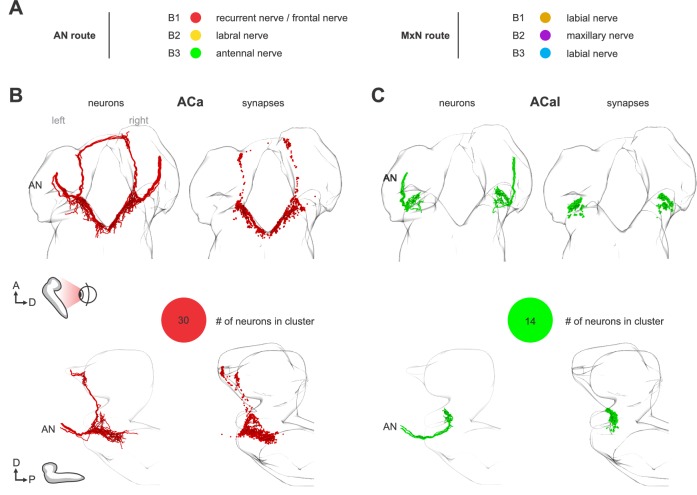
EM reconstruction of compartment forming sensory neurons and their synaptic sites.(A) Peripheral origin of AN and MxN axon bundles of pharyngeal nerves and nerve branches. The recurrent nerve, the frontal nerve labral nerve and the antennal nerve enter the brain as single morphologically indistinguishable nerve collective (termed as a whole the antennal nerve). The maxillary nerve and labial nerve also enter the brain as morphologically indistinguishable nerve collective (termed as a whole the maxillary nerve). (B, C) ACa, ACal, EM reconstruction and distribution of synaptic sites of afferent neurons as clustered in Figure 2—figure supplement 1. Each dot represents a synaptic site. Neurons and synapses are colored based on their peripheral origin (nerve). Number in colored circle represents number of sensory neurons in cluster.